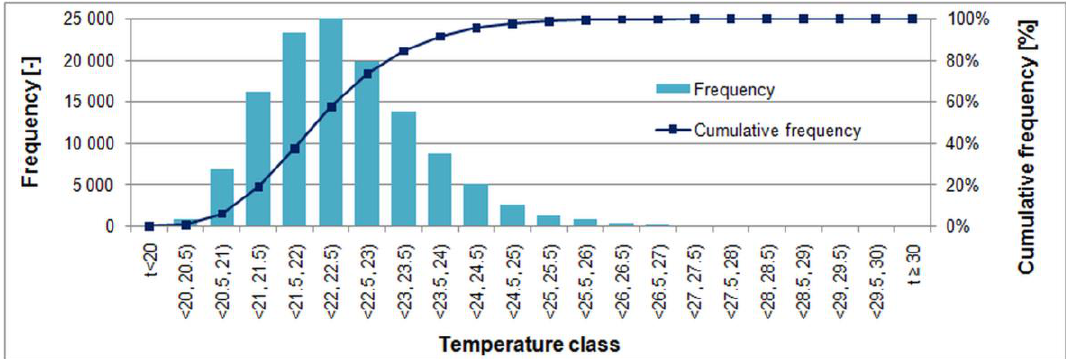
plete. Better way is to describe variance of measured variable by a histogram [79]. In the considered case, values from sensors T1-T9 were gathered and divided into temperature classes 0.5 °C wide (Figure 10). Temperatures within the range from 20 °C to 25 °C cov- ered 97.6% of the whole period.